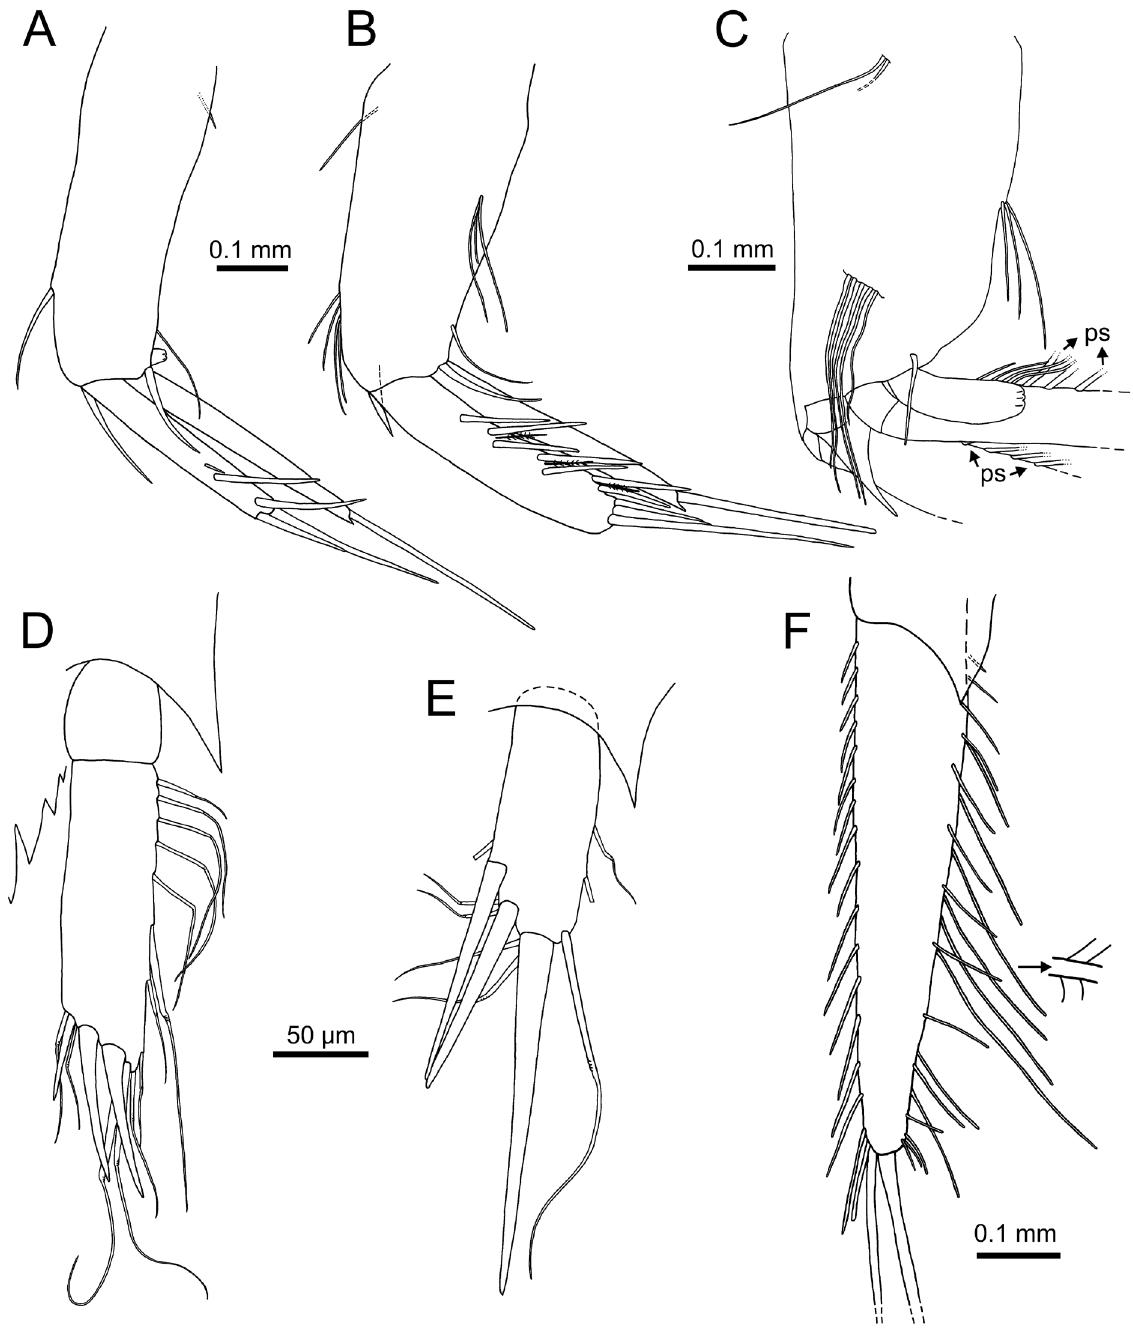
Fig. 15. Sarsinebalia ledoyeri sp. nov. Postovigerous female, paratype (MNCN 20.04/13708). A . Pleopod I, lateral view. B . Pleopod II, lateral view. C . Pleopod III, protopod and endopod appendix interna , inner side. D . Pleopod V, ventral view. E . Pleopod VI, ventral view. F . Right uropod, ventral view. A–B, D–E: same scale bars; A–B: plumose setae not illustrated; C: exopod and endopod plumose setose: setules not